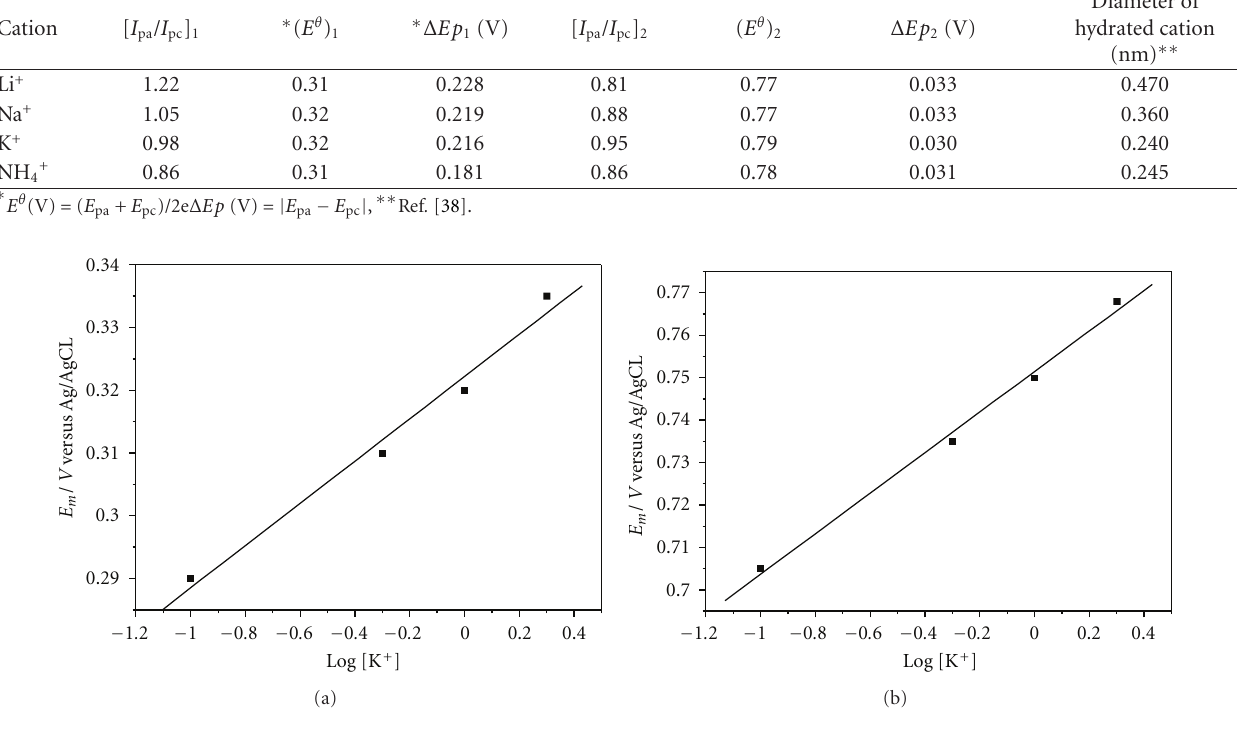
Figure 5: The dependence of the formal potential of CuNPSD on the logarithms of K + concentration ( v = 20mVs − 1 ): (a) peak I and (b) peak II.